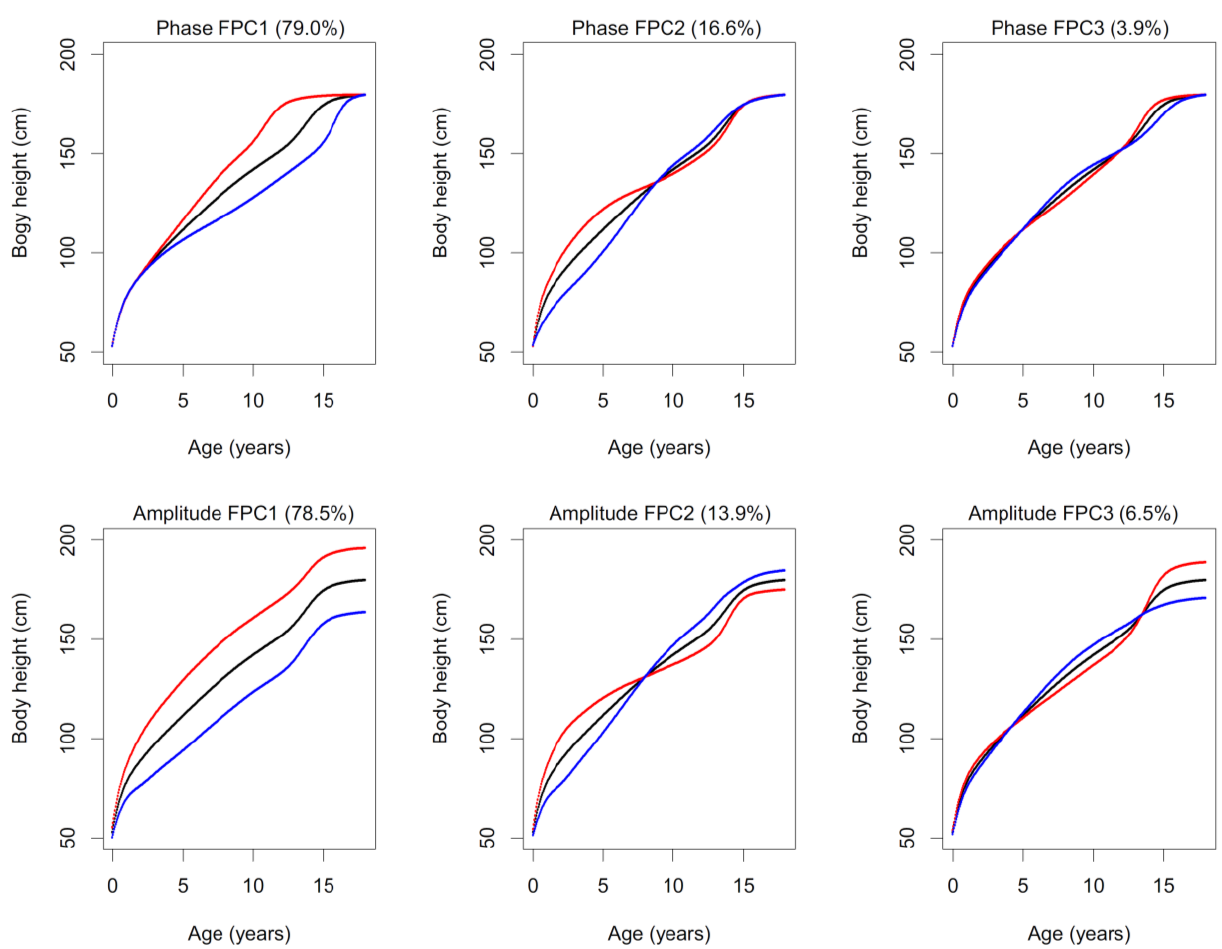
Figure 4. Functional Principal Component Analysis of the height data for boys in the Brno Growth Study: FPCA for phase (upper row) and FPCA for amplitude (lower row) variation—black line represents mean curve and color lines represent +3 Standard Deviations (red) and − 3 Standard Deviations (blue); percentages of variance are indicated in parentheses; FPC1–3 are Functional Principal Component 1 – 3).